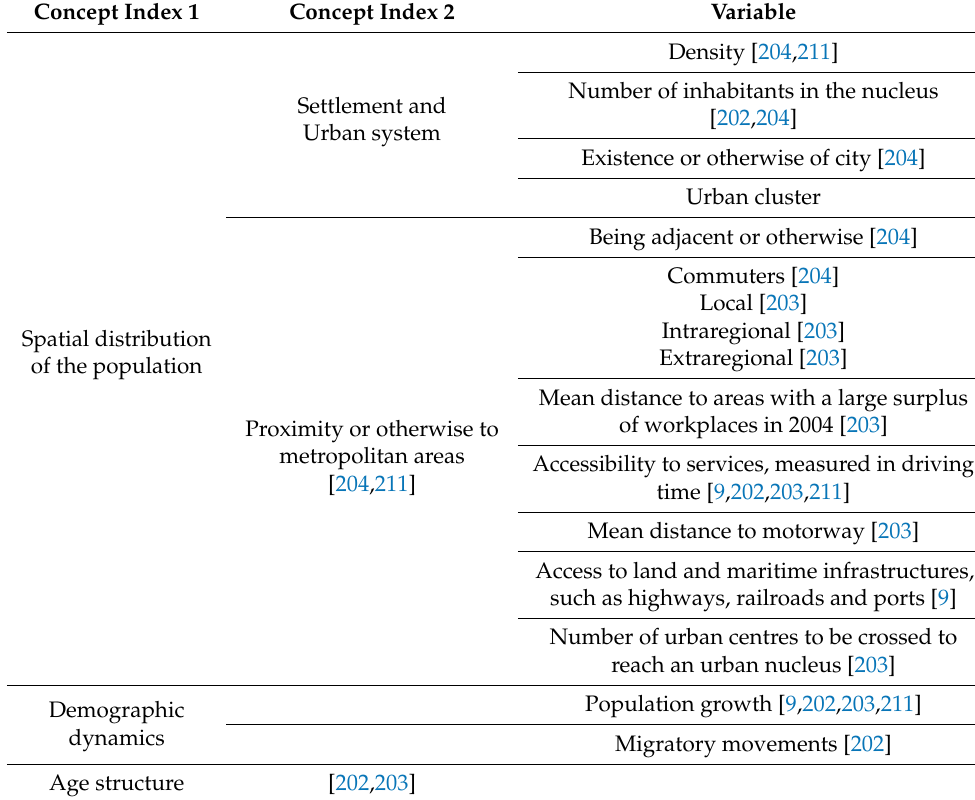
Table 2. Concept indices and variables applied, according to our literature